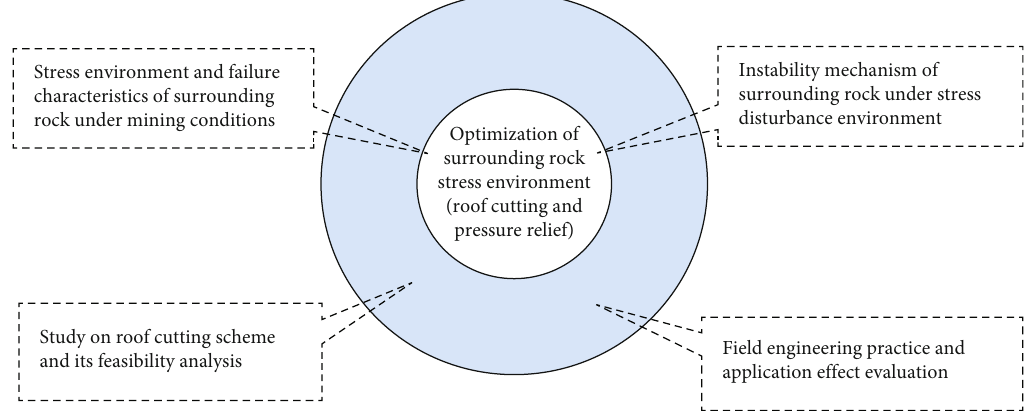
Figure 1: Research technology ideas for deformation control of surrounding rock along empty roadways.